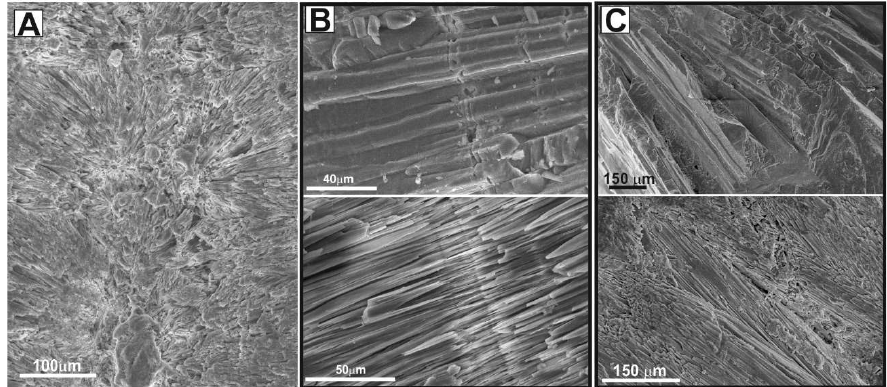
Figure 7. Details of the micro-fibrous texture of the prismatic crystals and the concentric layering of belemnite rostra. ( A – C ) Longitudinal thin section under TL ( A ), PL ( B ) and FL ( C ) microscopy (specimen PC-31-04) showing the micro-fibrous texture of the crystals (black arrows) and the concentric layering. Under FL, the concentric layering is enhanced: some layers display weak FL and micro-fibrous texture; they are separated by very thin and intense FL layers, in which the micro-fibrous texture is no evident. ( D – F ) Transversal fresh-cut sample (CE-25-04) under SEM. Prismatic crystals of calcite internally display a micro-fibrous texture ( E , F , red arrows). Perpendicular growth layering is also observable. Note that microfibers traverse the concentric growth layering ( F , white arrows). ( G , H ) Longitudinal ( G ) and transversal ( H ) thin sections (specimens PC-31-04 and PC-37-01, respectively) observed under backscattered ( B ) SEM. The micro-fibrous texture is observable as fibers displaying alternating light- and dark- grey colours. Note that the light-grey fibers traverse the concentric growth layers displaying an overall dark-grey colour (white arrows), which correspond to the thin layers that displays intense FL (see C ). Note also that, in transversal sections ( H ), the micro-fibrous texture is not observable in the inner part of the rostra (in the apical area) but progressively becomes more evident towards the external wall of the rostra.